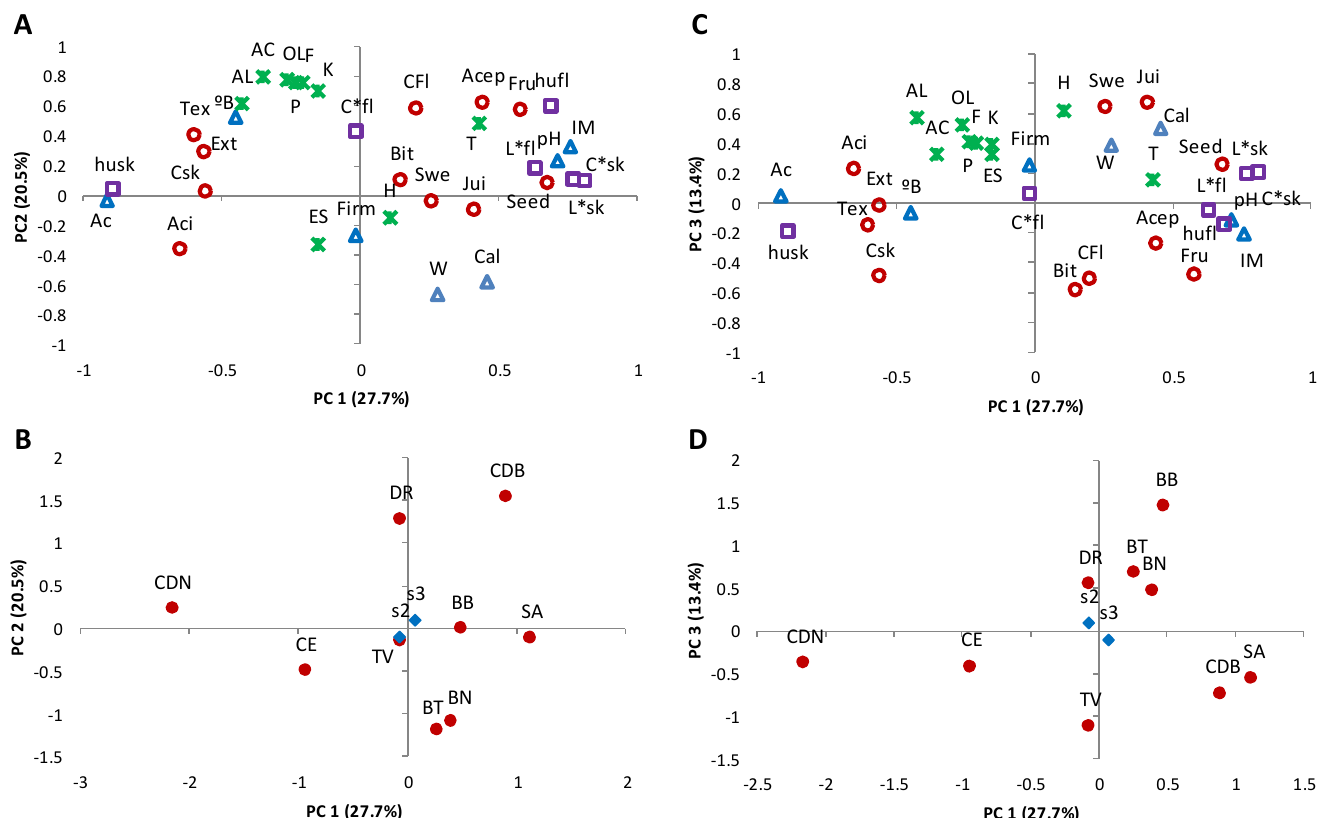
Figure 5. Loading plots ( A and C ) and score plots ( B and D ) after principal component analysis of the varieties, ripening stages, physicochemical, and sensory parameters and in the planes by three first principal components (PC1, PC2, and PC3). Physicochemical parameters ( △ ), weight (W), calibre (C), °Brix (°B), acidity (Ac), pH, maturation index (IM), firmness (Firm). Colour parameters (□), skin h* (hsk), C* (C*sk), L* (L*sk); fesh h* (hfl), C* (C*fl), L* (L*fl). Chemical families of volatile compounds ( ᚕ ), aldehydes (AL), acids (Ac), alcohols (OL), ketones (K), furans (F), pyrazines (P), hydrocarbons (H), terpenes (T), esters (ES). Sensory parameters ( ○ ), external appearance (Ext), skin colour (Csk), fresh colour (CFl), texture (Tex), sweetness (Swe), bitterness (Bit), juiciness (Jui), fruit flavour (Fru), overall acceptability (Acep).